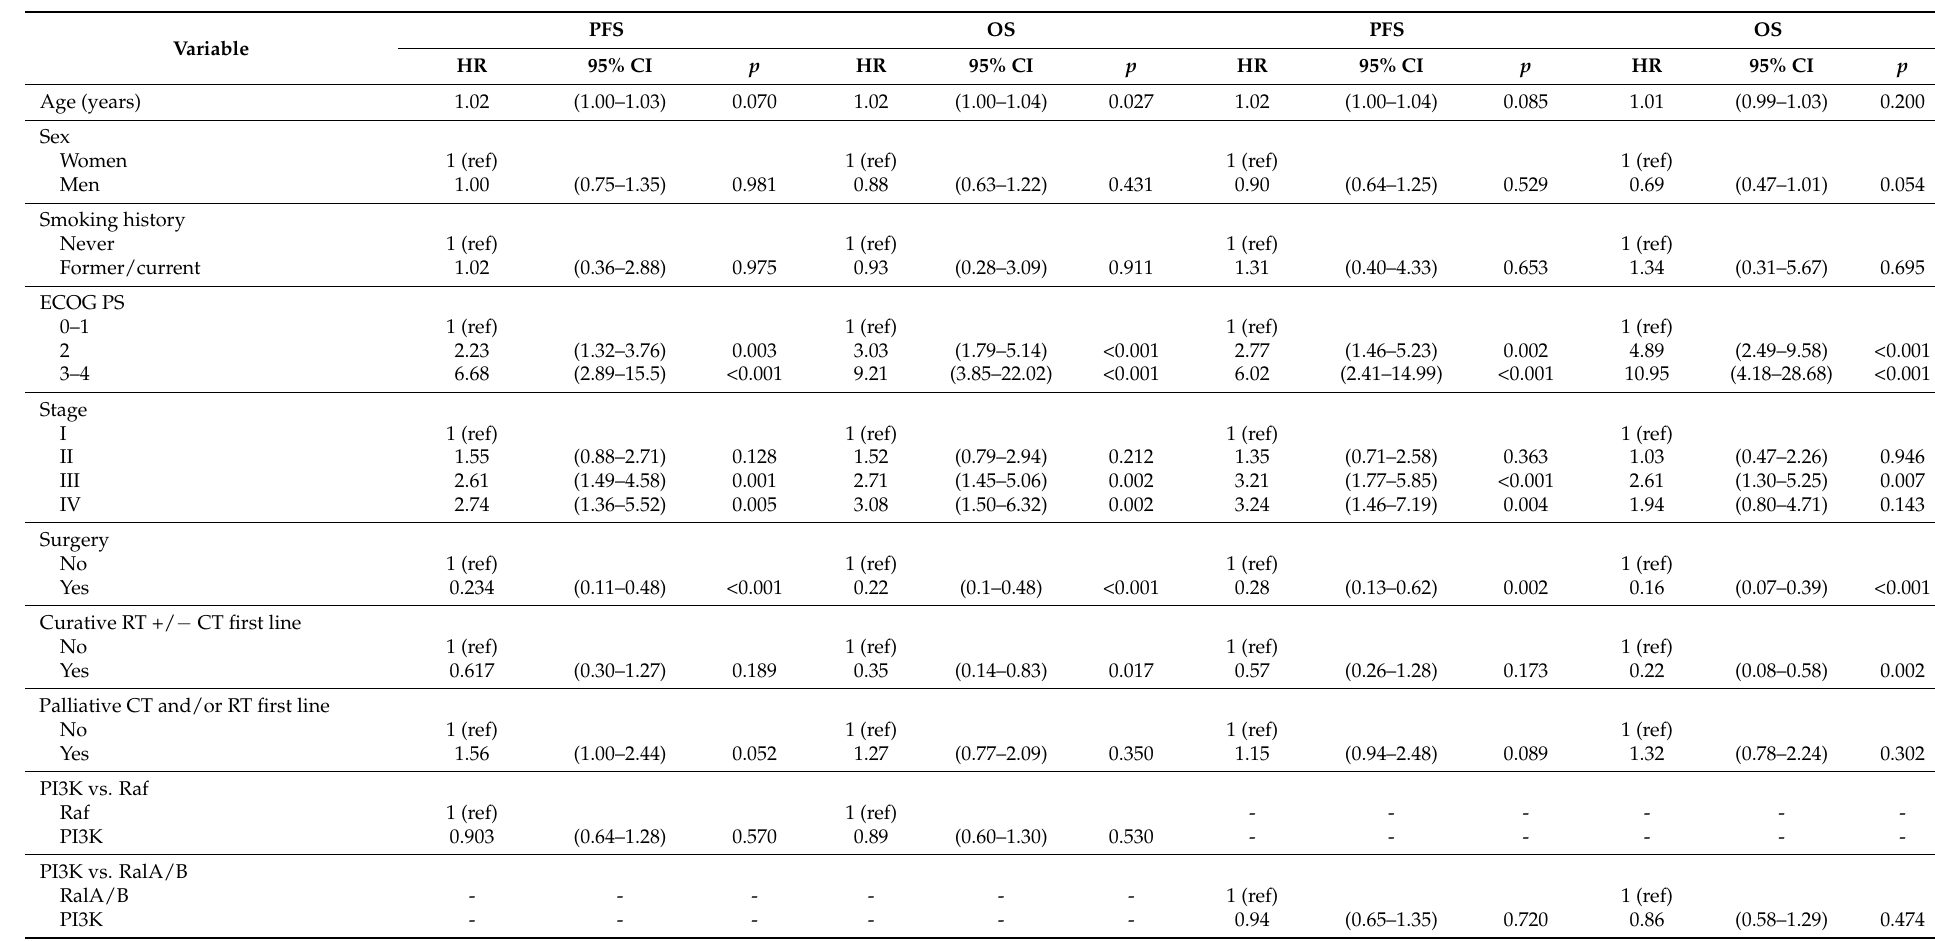
Table 5. Multivariable analyses of progression free survival and overall survival in stage I–IV patients with KRAS mutations favouring PI3K/Akt (G12D), Raf (G12C, G12A, G13D, Q61L/H) and Ral